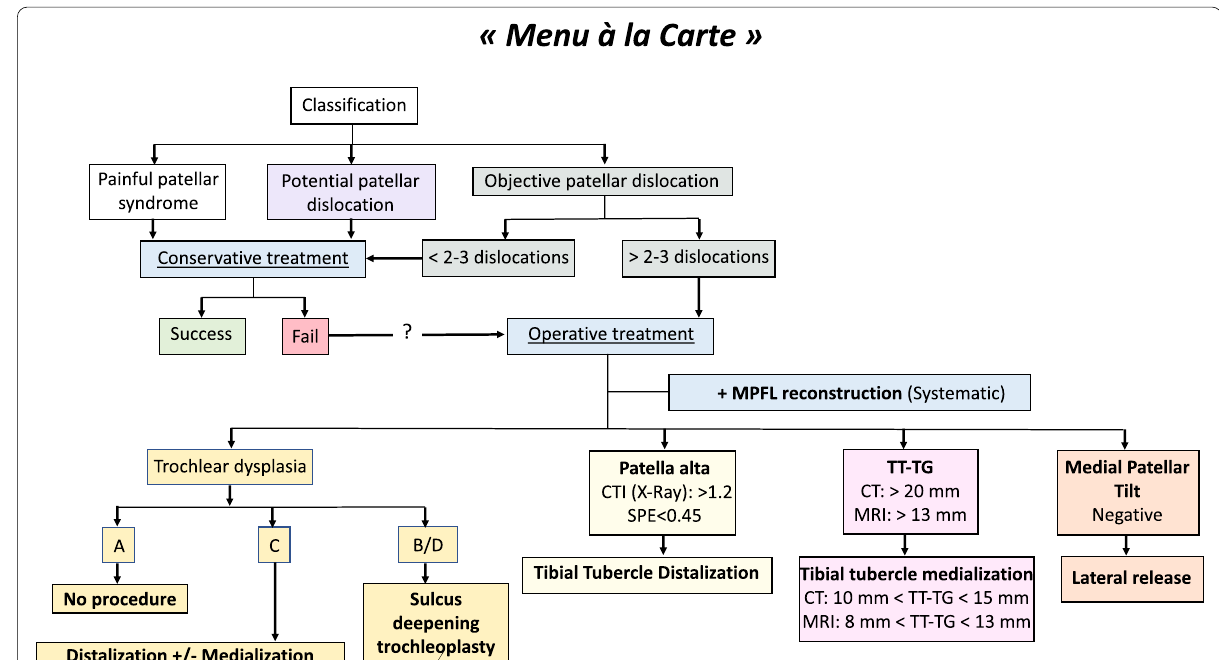
Fig. 5 The updated treatment algorithm for patellar instability. Each abnormality has to be evaluated and surgically corrected when indicated (“menu à la carte”)